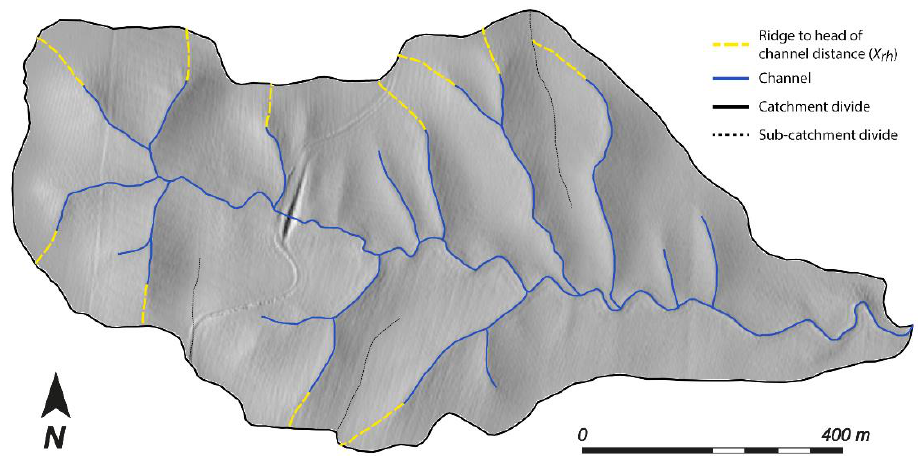
Figure 5. Schematic view of the ridge to head of channel distance ( X rh , represented with yellow-dashed lines) measured in catchment B. Channels appear represented in blue. The ridge to head of channel distance ( X rh ) can be defined as the distance measured from the head of the channel along the flow line to the divide of the catchment.